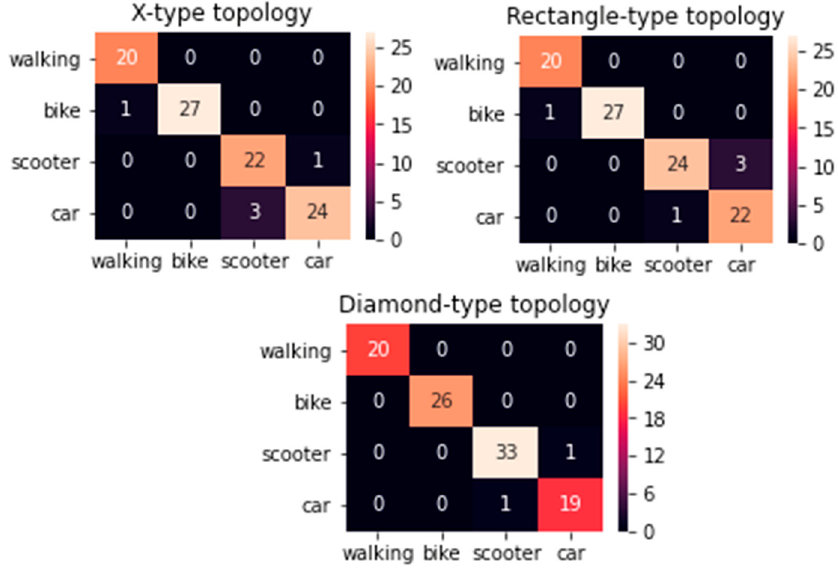
Figure 11. Confusion matrixes of three topologies for Wi-Fi.